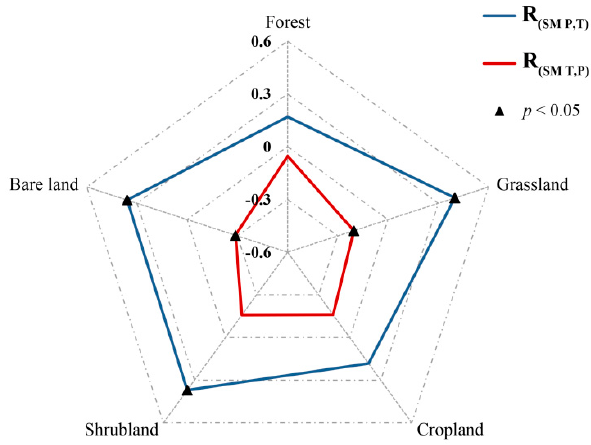
Figure 10. Partial correlation analysis between soil moisture and meteorological factors.